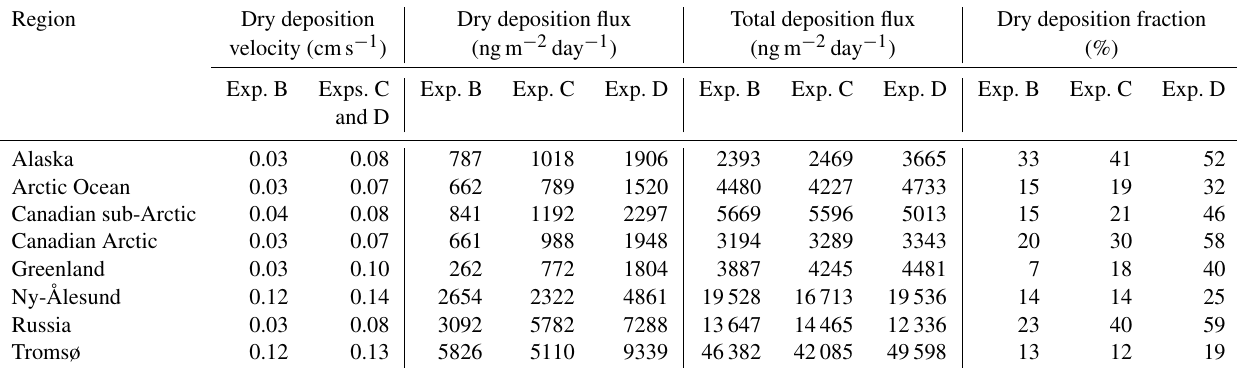
Table 5. GEOS-Chem simulated BC dry deposition velocity (cms − 1 ) , dry deposition flux (ngm − 2 day − 1 ), and fraction of dry to total deposition (%) in the